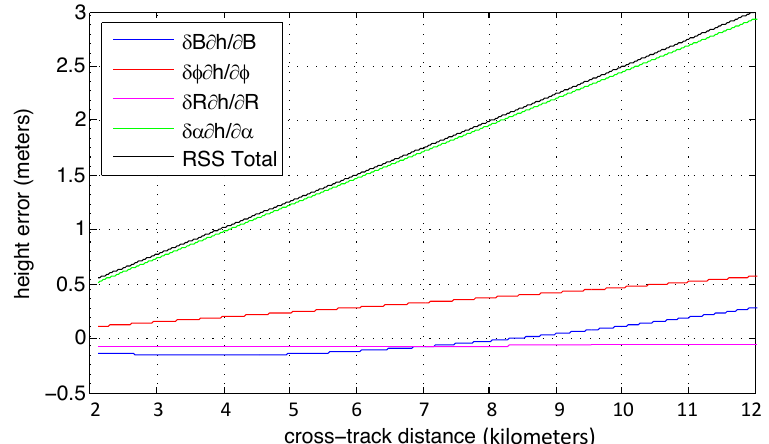
Figure 1. An estimate of the contributions of residual error terms to a systematic height artifact across the swath. Note that the contibuting factors can vary with sign so the slope can vary in both directions. Uncertainty in knowledge of the baseline roll, δα is the dominant source of error for GLISTIN-A using the EGI flown prior to